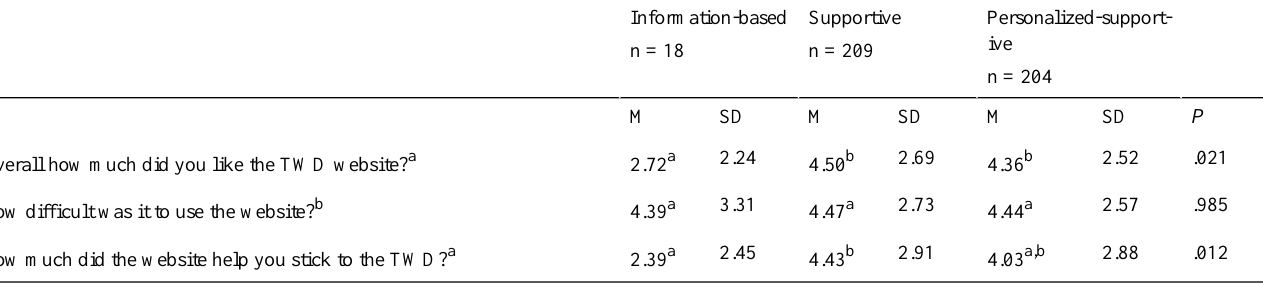
209Information-based n = 18